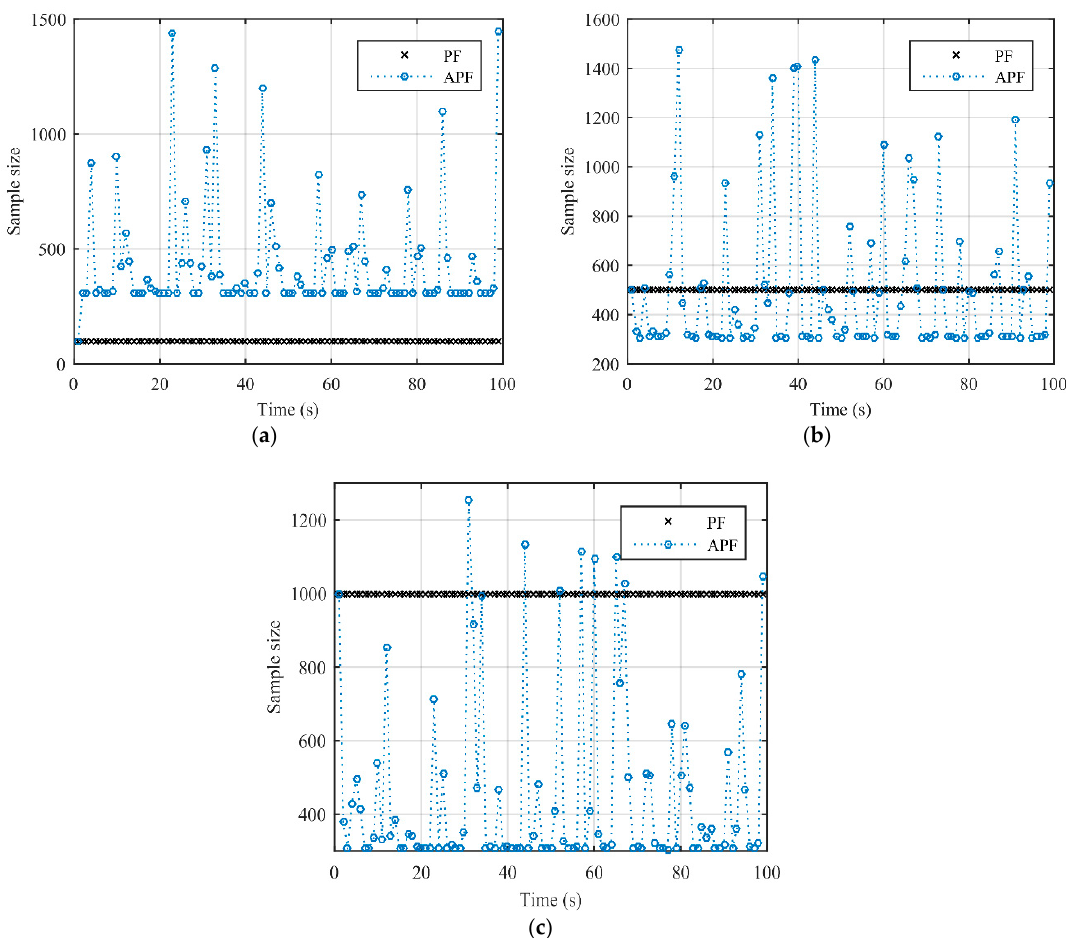
Figure 2. Changes of sample size with different initial sample size. ( a ) The initial sample size is 100. ( b ) The initial sample size is 500. ( c ) The initial sample size is 1000.